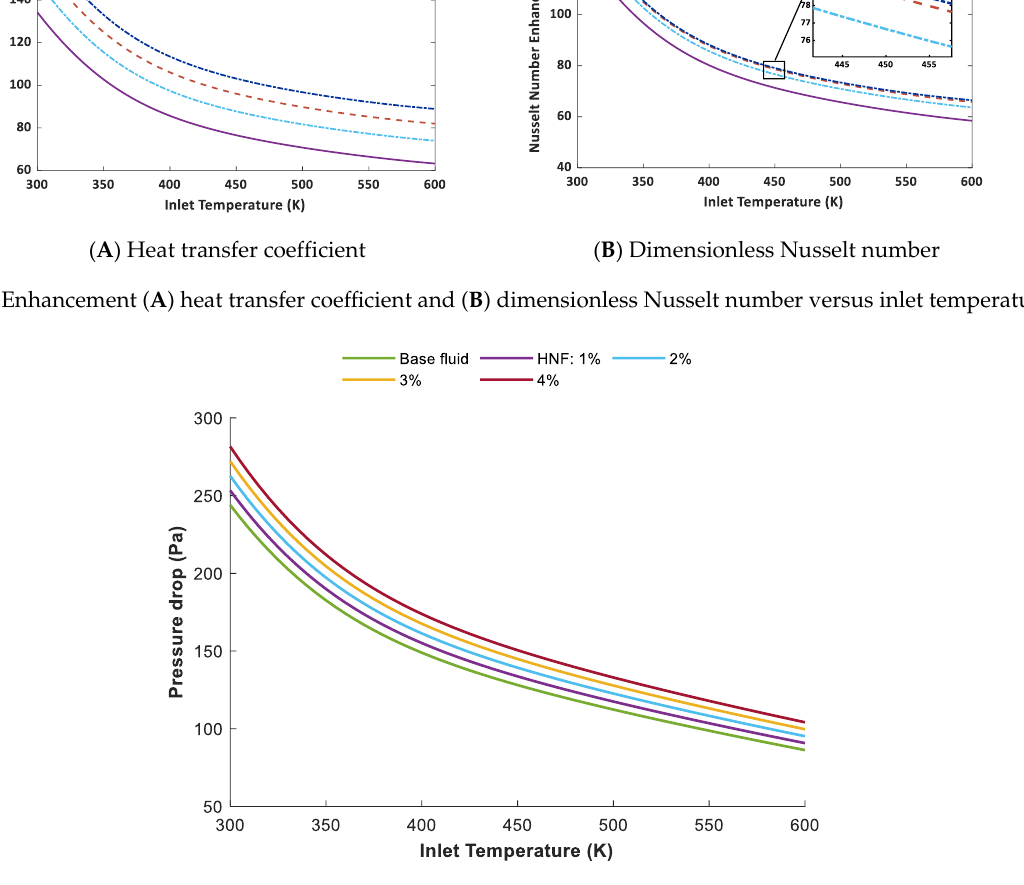
Figure 9. Pressure drop for the base fluid and hybrid nanofluids at different temperatures and concentrations.